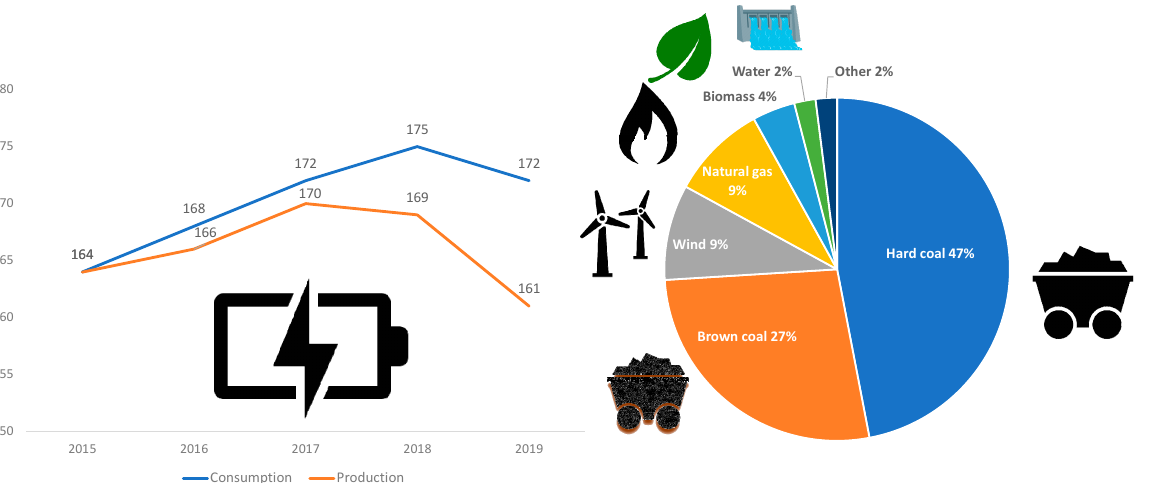
Figure 1. Distribution of coal production and consumption in Poland in 2020. Source: Own research based on Sandbag, Agora Energiewende (accessed on 2 November 2021).